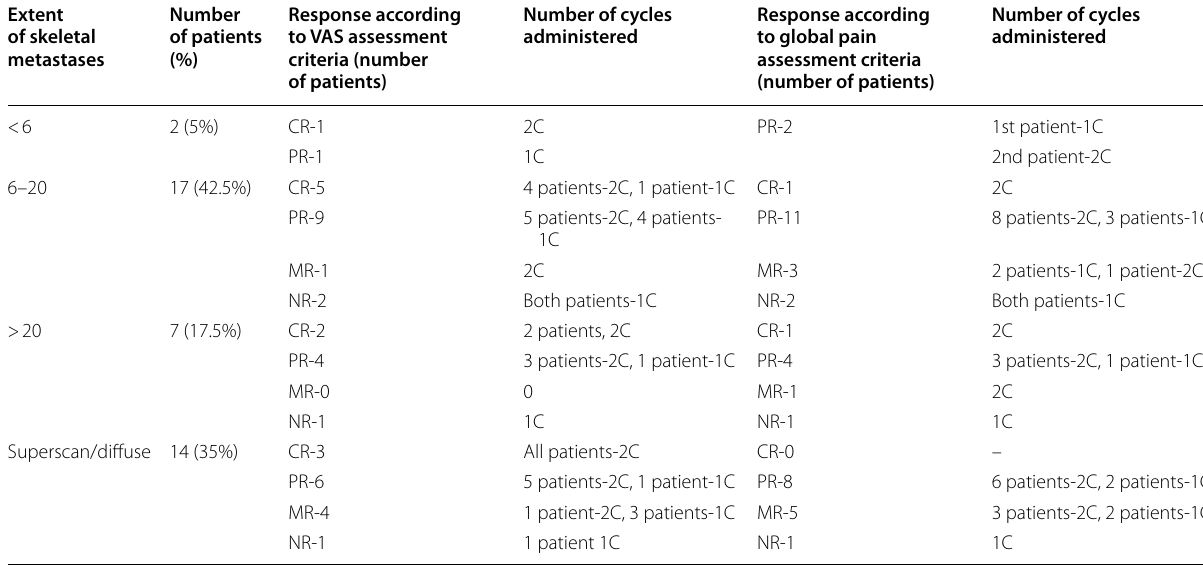
Table 3 Response and number of [ 177 Lu]Lu-DOTA-ZOL treatment cycles administered according to the extent of disease